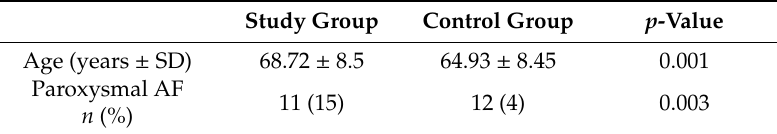
Legend: AF—atrial fibrillation.